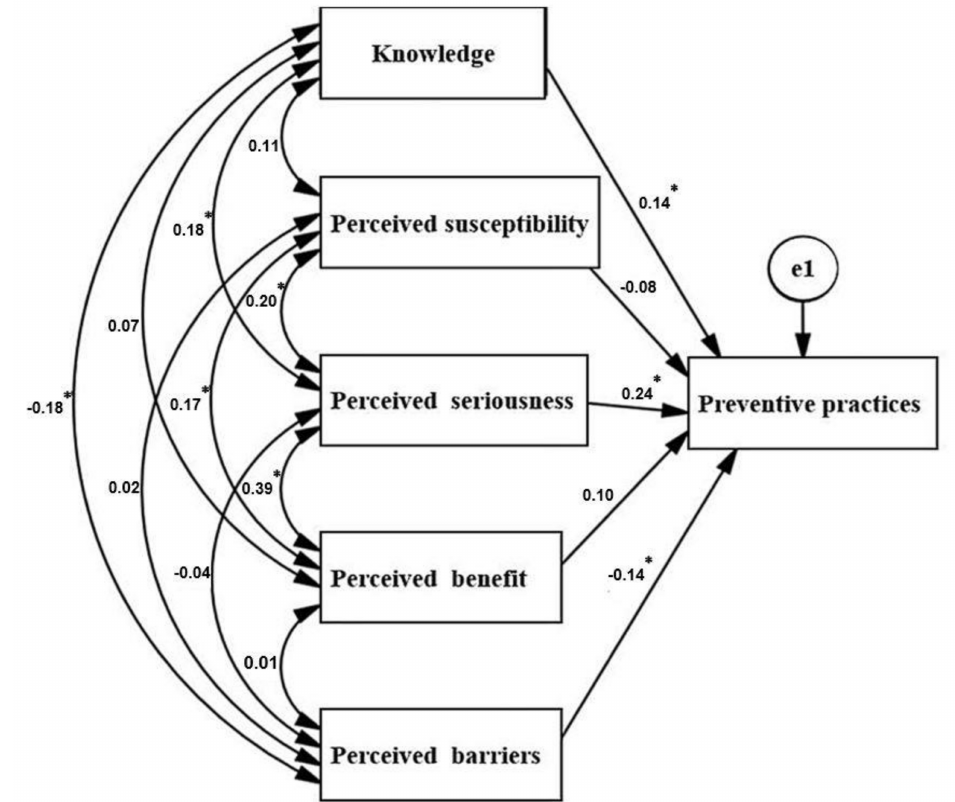
Figure 2. Knowledge and health belief predictors of preventive practice. Note: The numbers in the single-headed arrows represent path coefficients, the parameters that affect the size of the independent variable on the dependent variable. e1: measurement error. A double-headed, curved arrow indicates that variables are correlated, numbers representing correlation coefficients. * p <